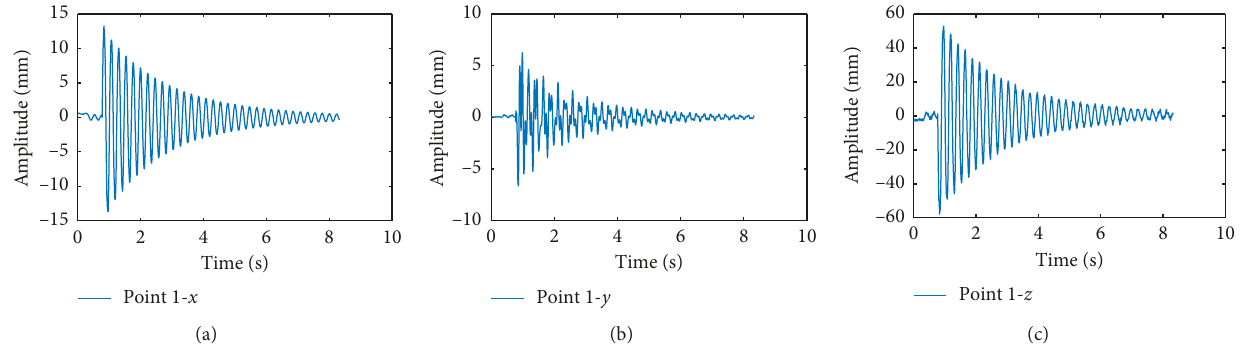
Figure 6: Vibration displacement curves of point 1 under impact excitation: (a) X direction, (b) Y direction, and (c) Z direction.